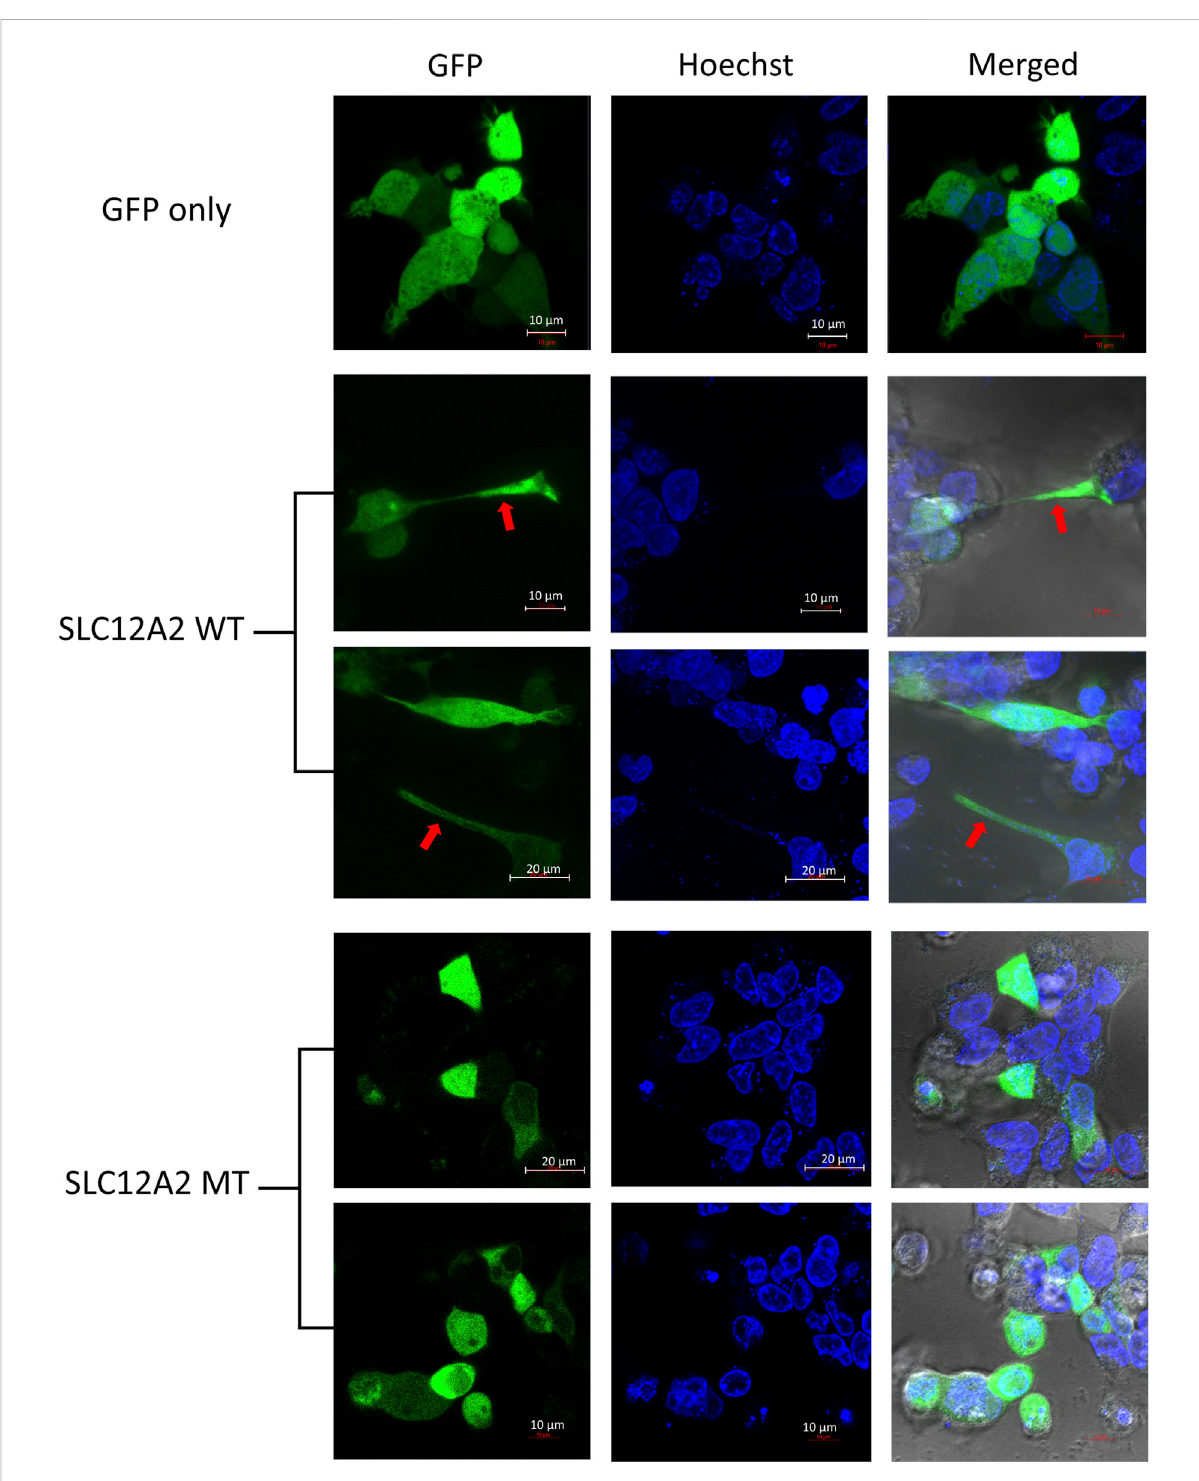
FIGURE 3 SLC12A2WTHEK293expressingcellsdisplaydistinctmorphologynotobservedinmutant-expressingcells.LiveHEK293cellsexpressingWTor MT GFP-tagged SLC12A2 protein and stained with Hoechst were observed using confocal microscopy 72 h post transfection. The red arrows point to axon-like structures present in the WT- SLC12A2 population of